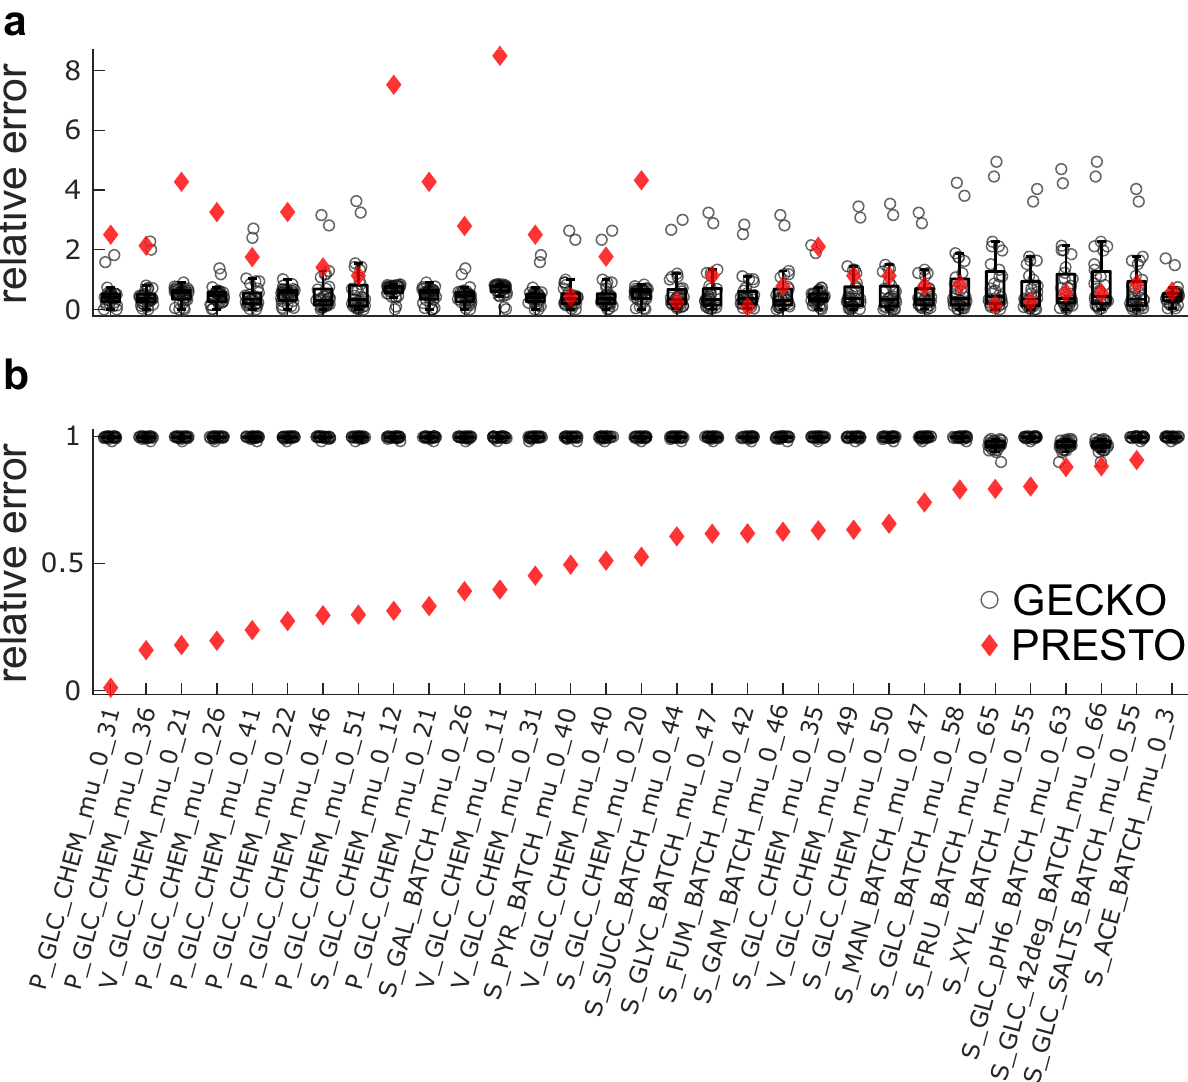
; b abundances of enzymes measured in all rates were bounded by 1000 mmol hgDW conditions were used as additional constraints. Missing data points originate fi c